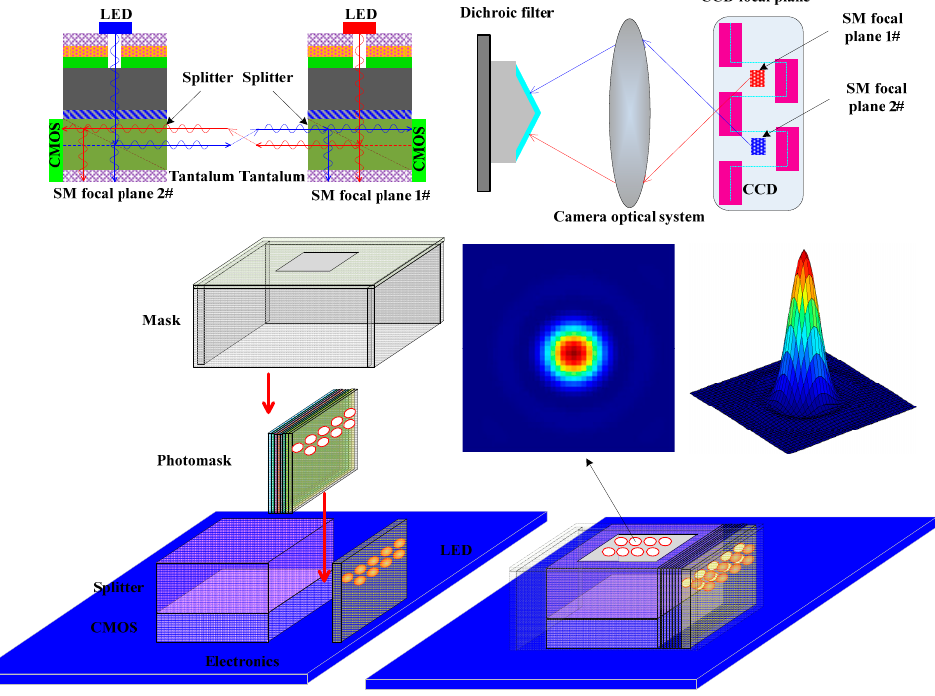
Figure 5. Integrated packaging of the SM point-source focal plane.